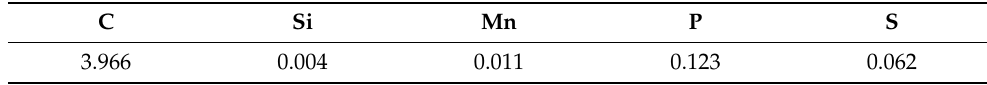
Table 4. Composition of semi-steel (mass